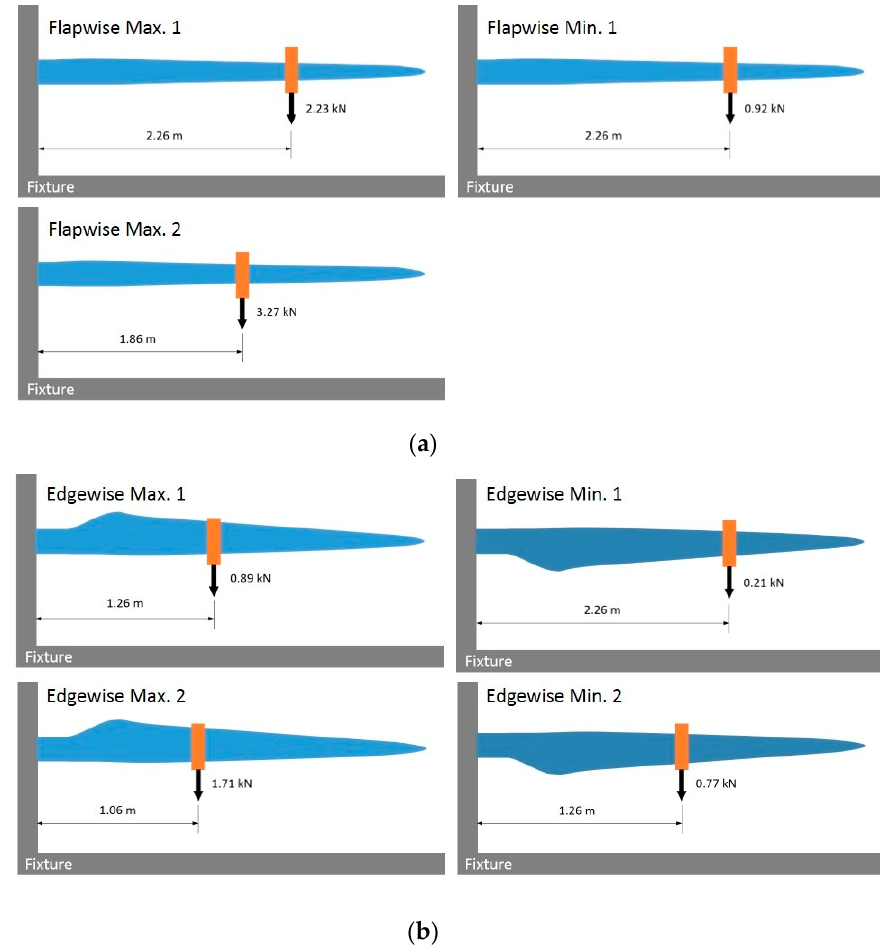
Figure 14. The test loads: ( a ) flapwise direction and ( b ) edgewise direction.